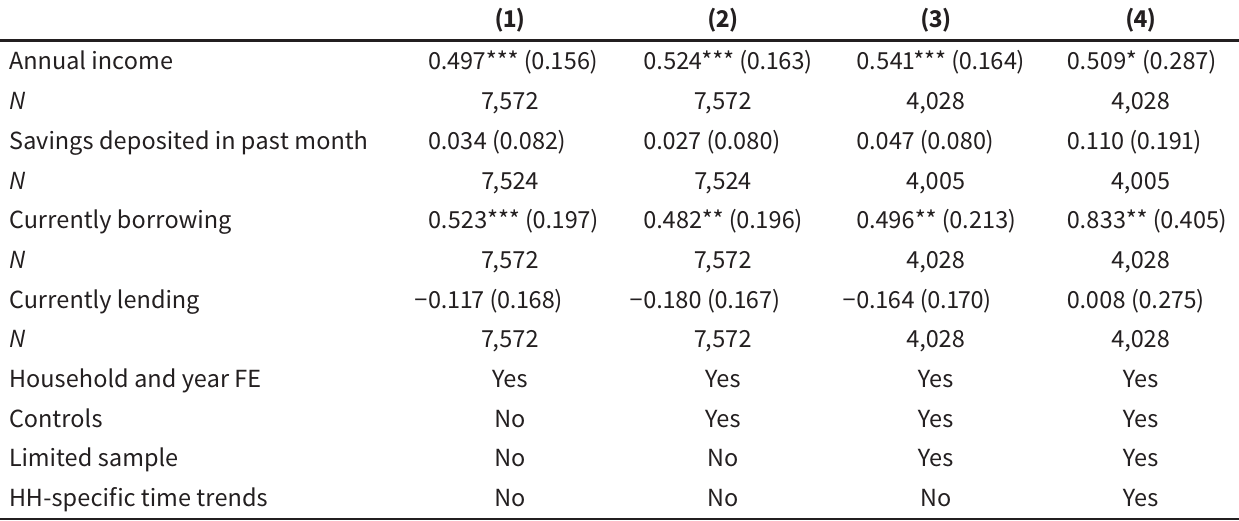
Changes in income and financial behavior ( asinh ) as son’s migration status